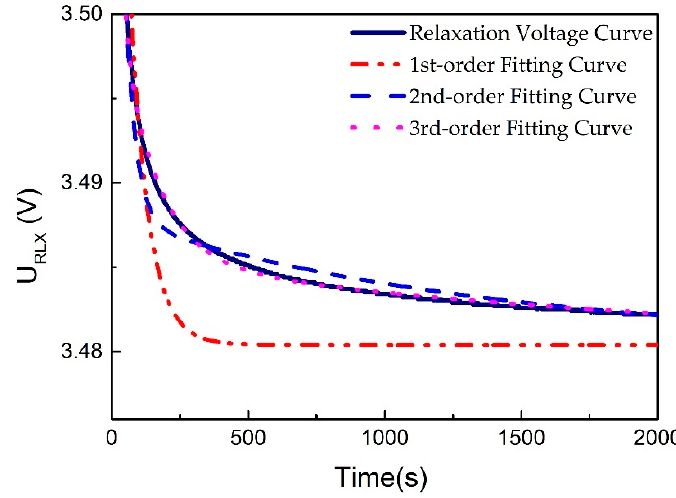
Figure 2. Fitting curves with different orders of ECM.